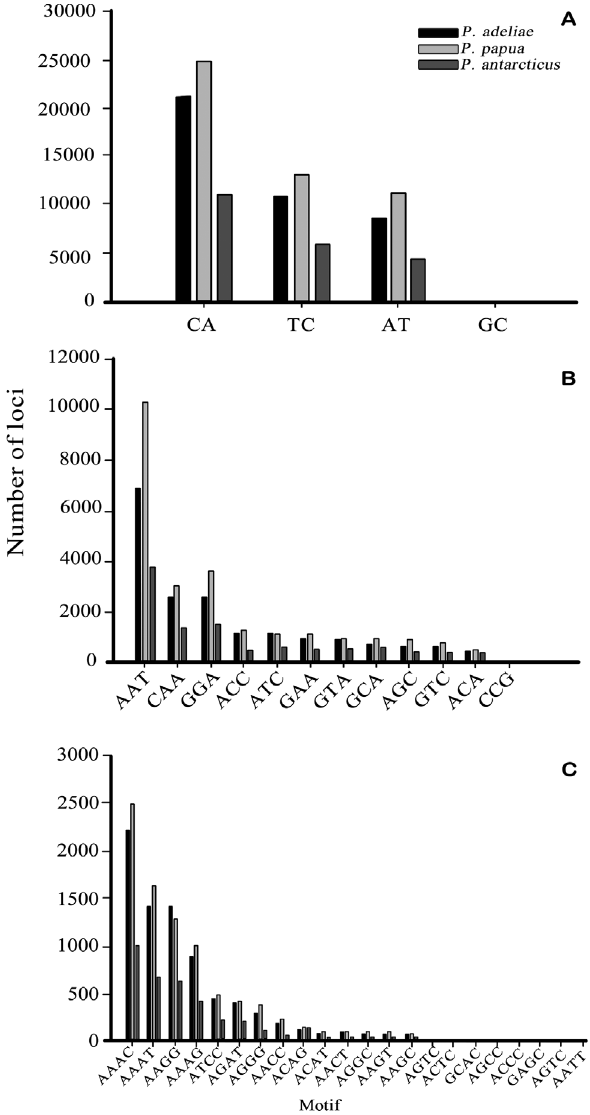
Figure 2 - Number of dinucleotide (A), trinucleotide (B) and tetra- nucleotide (C) loci with different motifs identified in P. Adeliae (black bar) , P. papua (light gray bar) and P. antarcticus (dark gray bar) .